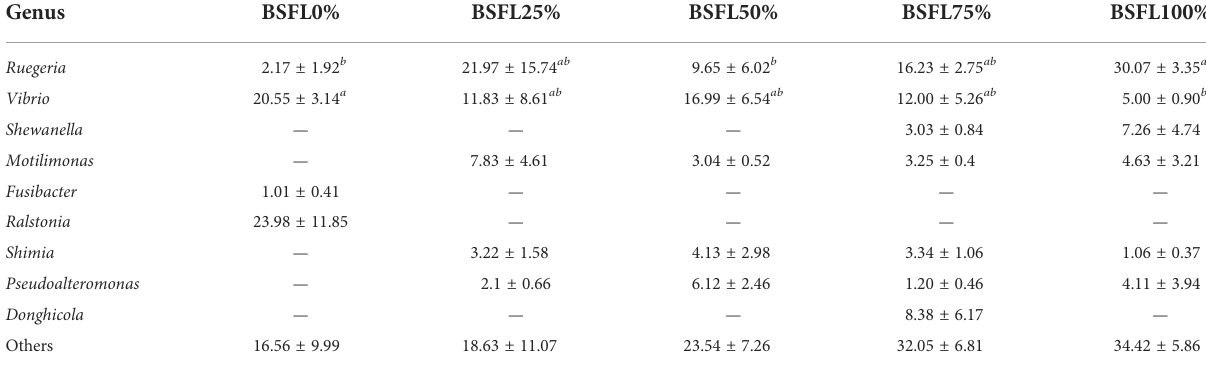
TABLE 7 Relative abundances (%) of bacterial genus in the intestine of L. vannamei . Genus BSFL0% BSFL25% BSFL50% BSFL75%